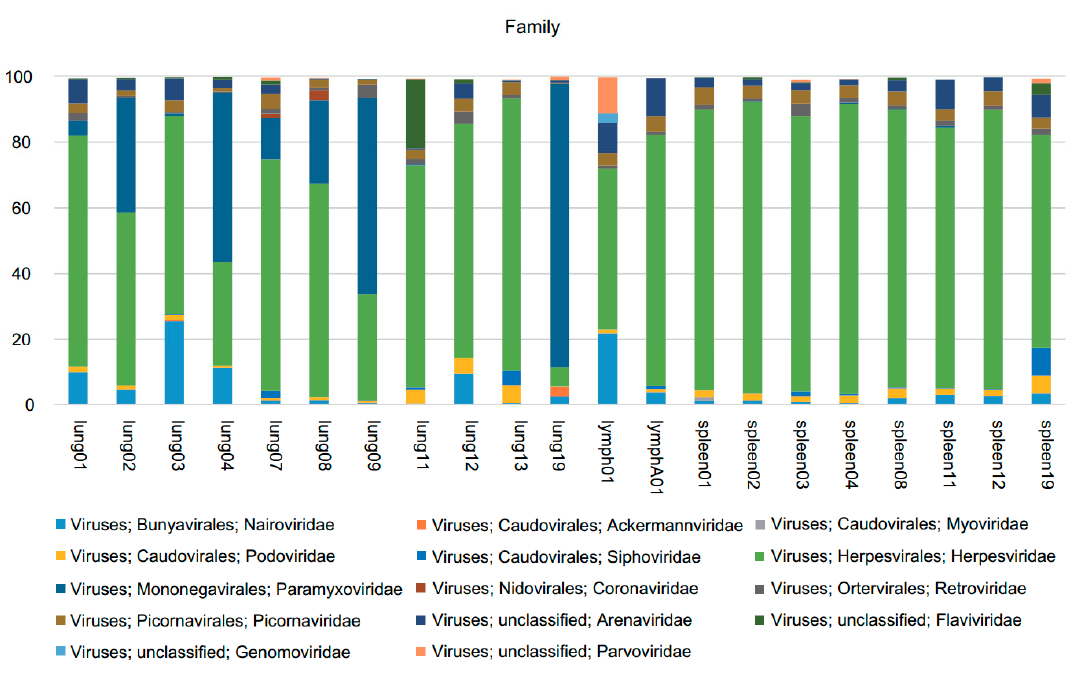
Figure 1. The percentage of sequences related to the most abundant viral families among all virus reads, indicated in the same colors for each main viral category. Taxonomic classification of viruses is consistent across samples. Samples are characterized according to the number of sequences from each sample classified by taxonomic family. Virus families are indicated by the color code on the bottom.